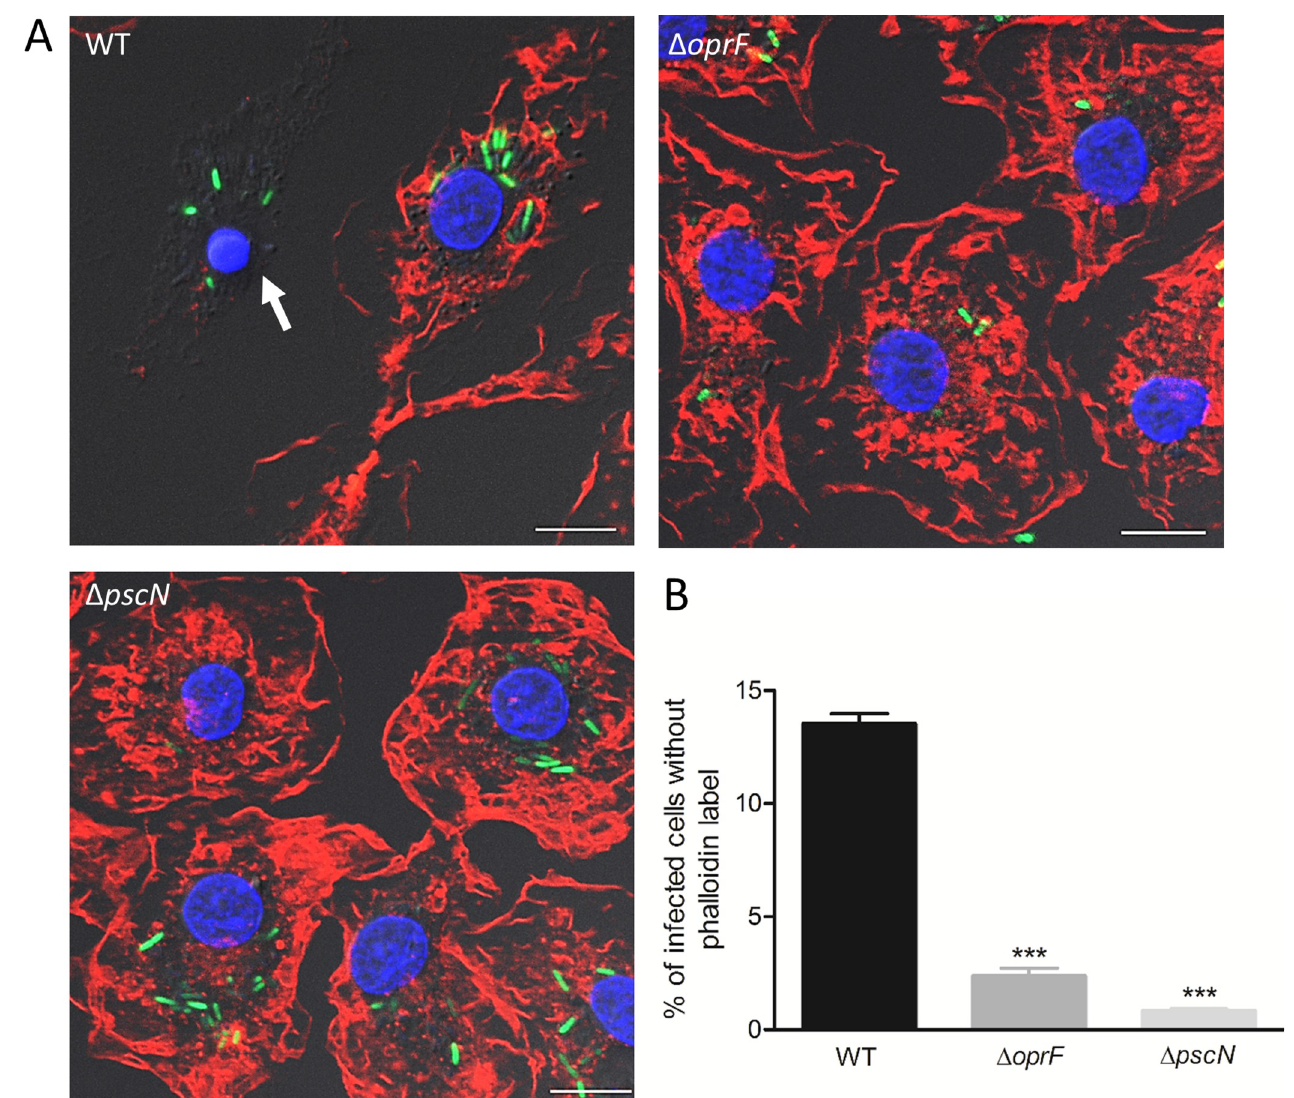
Fig 7. Visualization and quantification of lysis of infected primary human macrophages driven intracellularly by P . aeruginosa strains. HMDMs were infected with GFP expressing PAO1 WT, Δ oprF , and Δ pscN strains. After phagocytosis, cells were maintained in RPMI supplemented with gentamicin. Cells were imaged 2 hrs post-phagocytosis after staining with phalloidin (A) and lysis was quantified (B) by counting infected cells lacking cortical labeling (indicated by arrows). Scale bar is equivalent to 10 μ m. Percentage of lysed cells with intracellular bacteria out of total number of infected cells was plotted. Error bars correspond to standard errors from two independent experiments. At least 200 cells were counted per strain. The asterisks indicate P values (One way ANOVA, where all strains were compared to WT using Bonferroni’s multiple comparison test, ��� P < 0.001), showing statistical significance with respect to